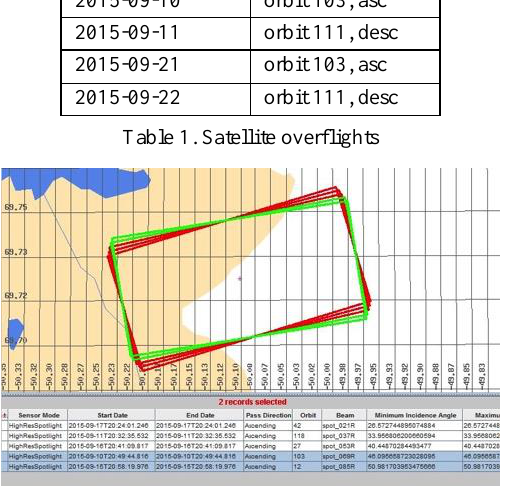
Figure 2. Area of interest, west Greenland north of Ilulissat